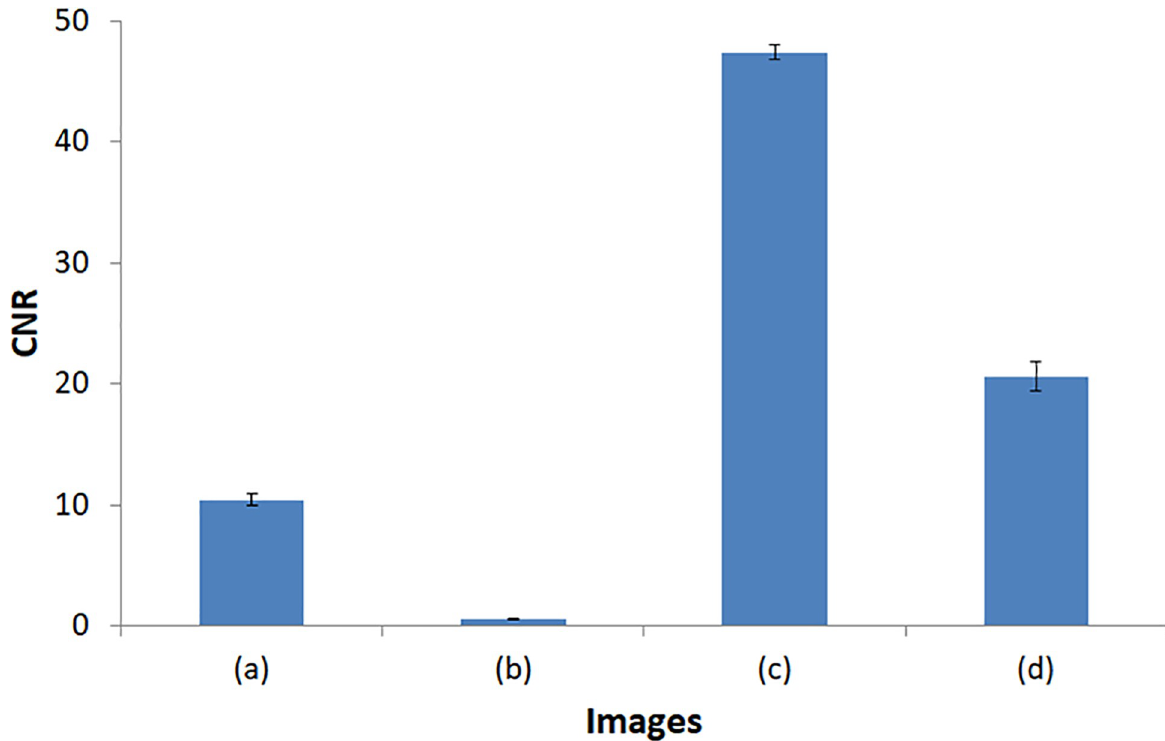
Fig 12. Contrast-to-noise ratio (mean ± standard deviation) for quantitative image quality of the multi-energy CT imaging in Fig 8.